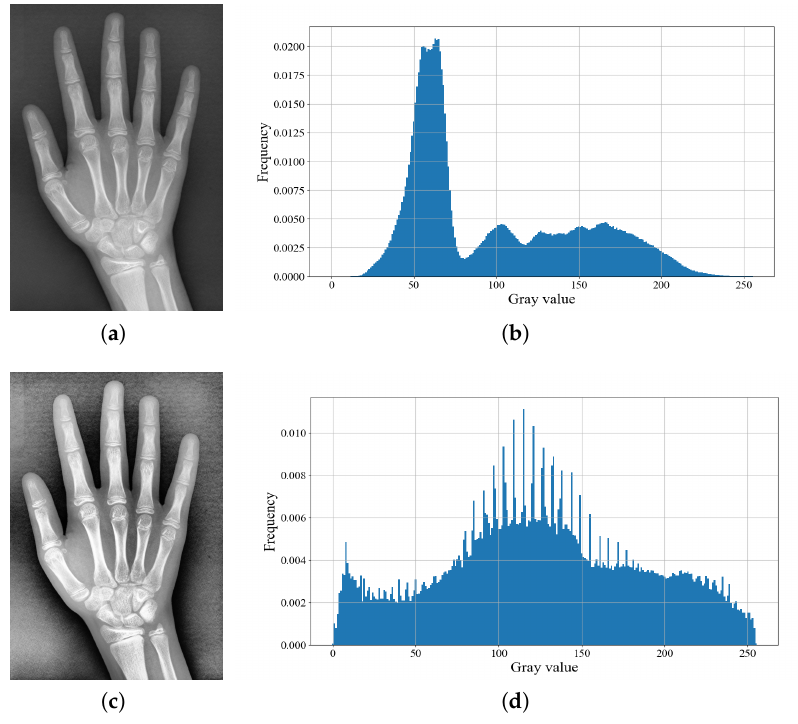
Figure 3. Effect of the histogram equalization operation. ( a ) The original image; ( b ) original histogram; ( c ) the improved image by histogram equalization; ( d ) histogram after